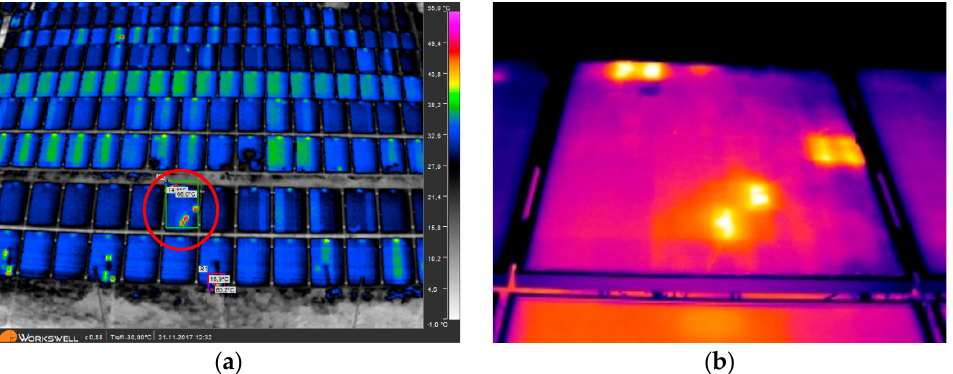
Figure 6. Thermographic analysis for an incident of broken glass: ( a ) aerial IR inspection, and ( b ) ground-level IR inspection. The red circle in ( a ) identifies the affected PV module.